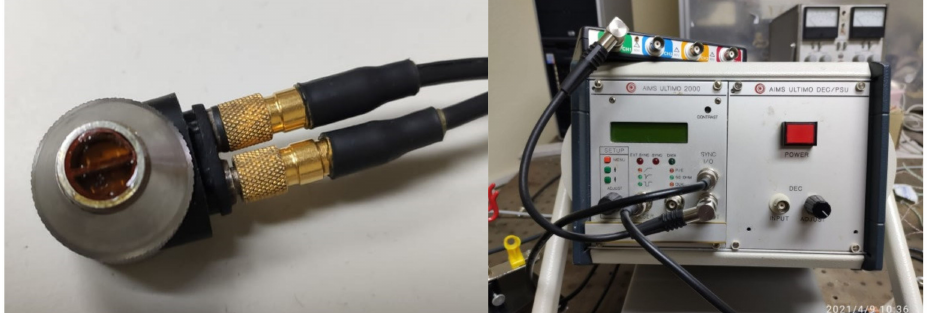
Figure 1. Ultrasonic transducer ( left ) and equipment ( right ) used for the experiments. The properties of the ultrasonic pulses (intensity and frequency) that arrive at the interface between the transducer surface and the drop samples depend on the settings of the ultrasonic pulser, the oscilloscope and the transducer